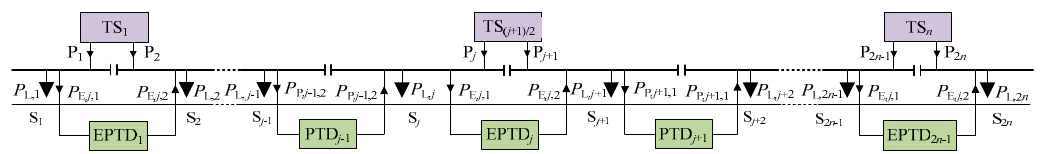
Figure 11. Simplified model of the modified railway system and its electrical description